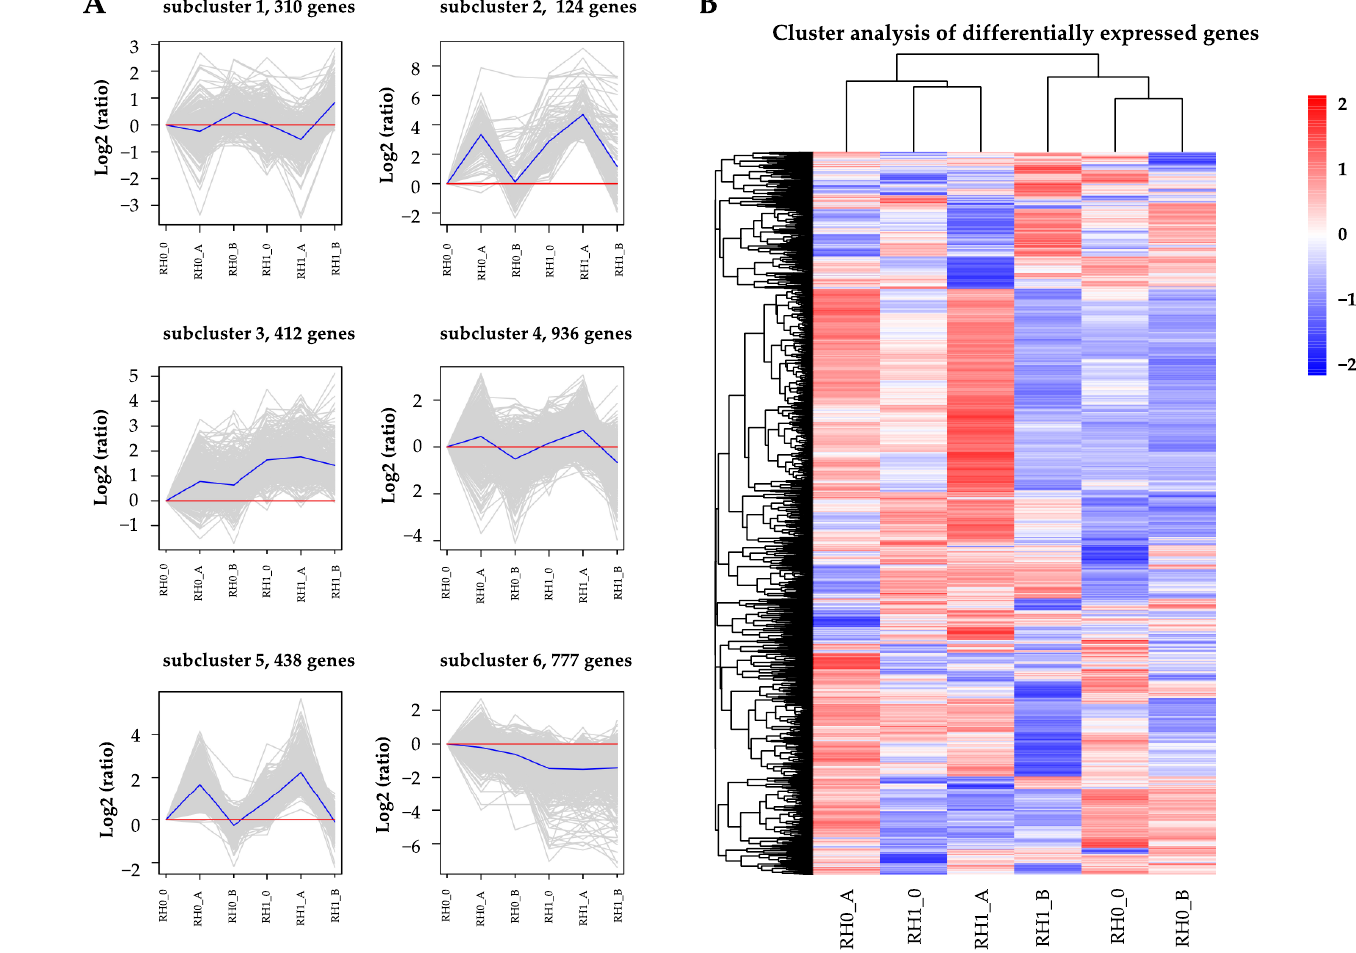
Figure 3. Expression patterns of differentially expressed genes (DEGs) at different development stages of two-type roots in A. beshanzuensis . ( A ) K-means clustering of the identified DEGs at different development stage of two-type roots in A. beshanzuensis . All the identified DEGs were classified into 6 clusters. ( B ) Cluster analysis of the identified DEGs at different development stage of two-type roots in A. beshanzuensis .